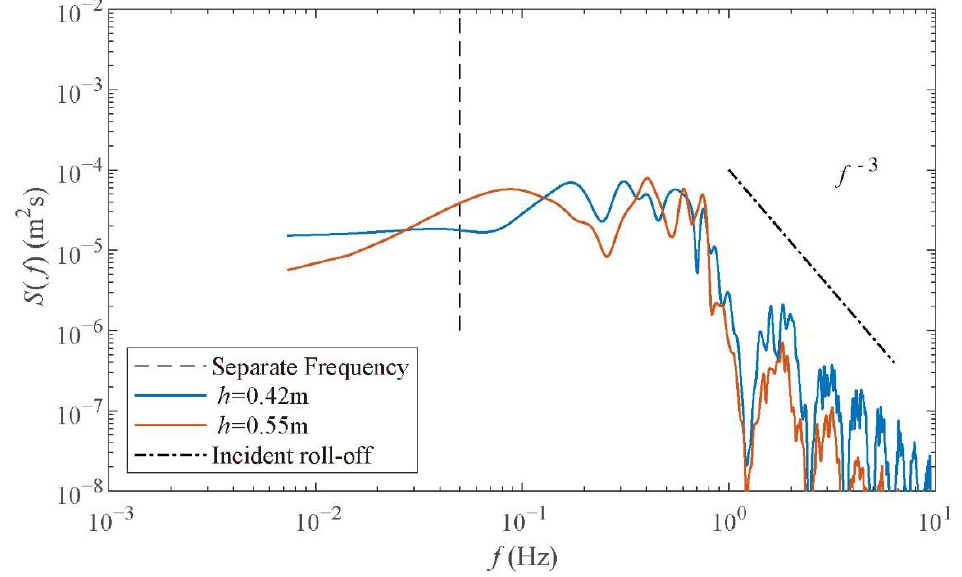
Figure 8. Swash spectrum evolution with the same wave condition and different experimental water depths on the barred beach (T0B and T11B). The black dash line is the separation frequency of the incident swash band and infragravity swash band.